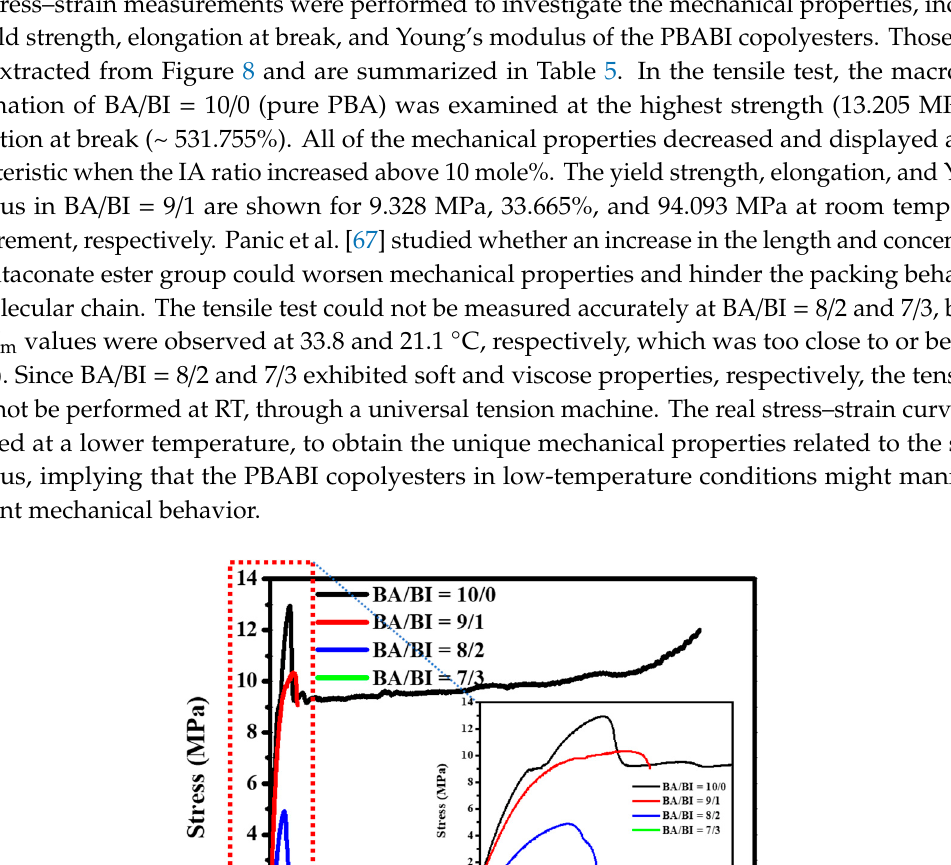
Figure 7. Shore D values at different UV curing times of the PBABI copolyesters.